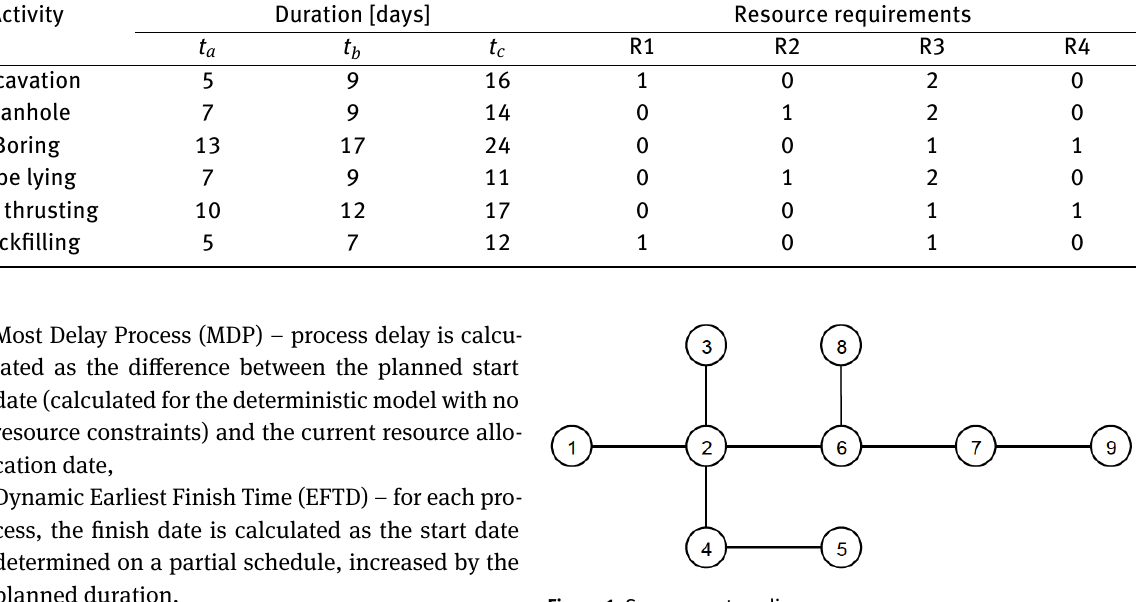
Figure 1: Sewage system diagram